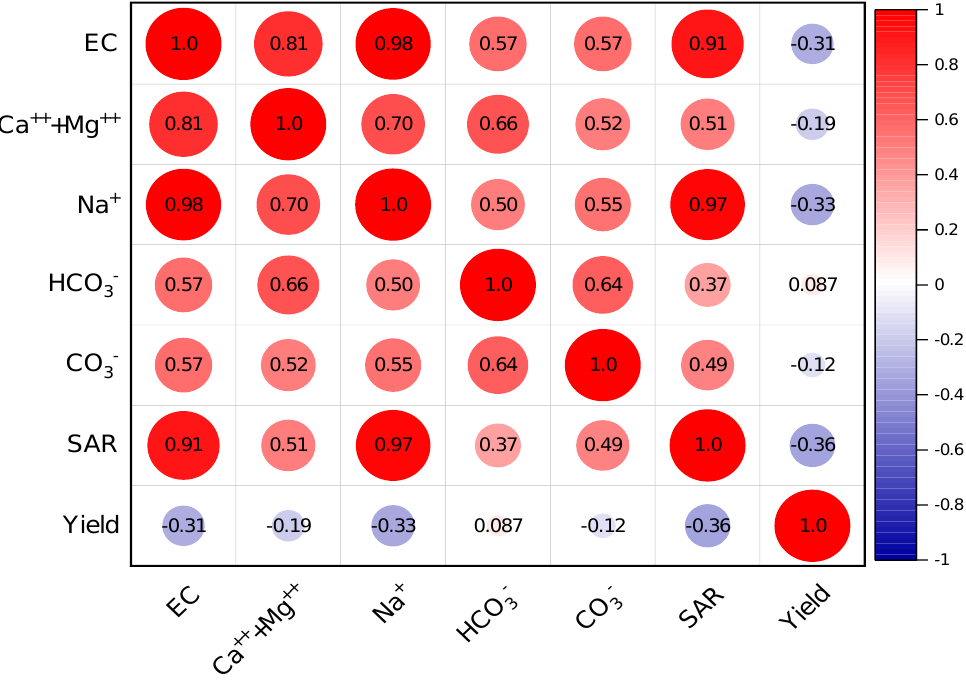
Figure 8. Correlation analysis among irrigation water parameters and cotton yield.